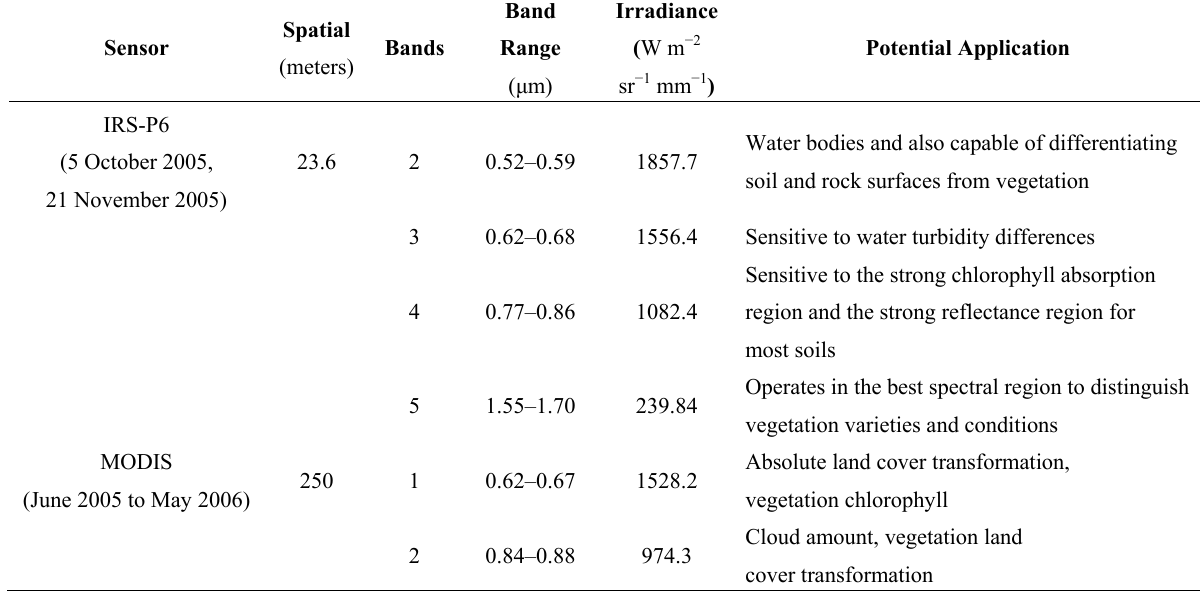
Table 1. The characteristics of satellite data used in this study. IRS-P6-LISS3 (Indian Remote Sensing Satellite with Linear Imaging Self-Scanning (IRS LISS)) 4-band reflectance and MODIS Terra 2-band reflectance data characteristics used in this